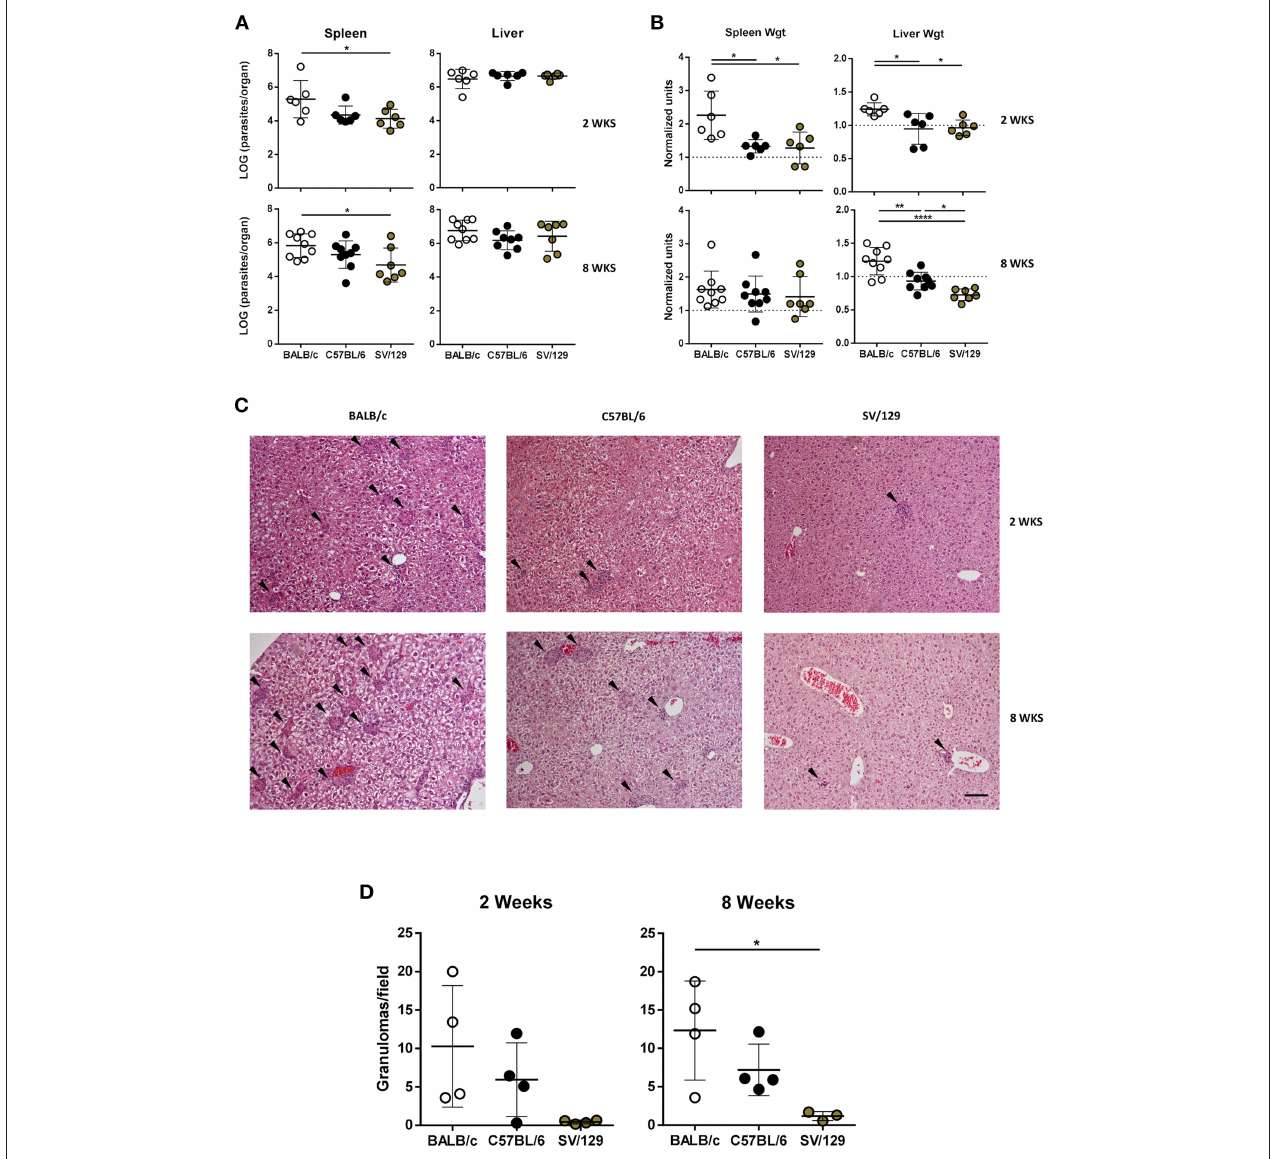
FIGURE 1 | Parasite burdens, organ weights, and hepatic granulomas quantification in the three murine strains 2 and 8 weeks after infection with L. infantum . BALB/c (white circles), C57BL/6 (black circles) and SV/129 (brown circles) mice were infected intraperitoneally with 1 × 10 8 L. infantum promastigotes and euthanized 2 or 8 weeks after. Aged matched non-infected controls were euthanized at the same time-points. (A) Hepatic and splenic total parasite burdens (determined by limiting dilution). (B) Relative splenic and hepatic weight alterations with infection (normalized by the controls average organ weights). (C) Hepatic granuloma morphology (representative images of H&E stained liver slides; 100X magnification; arrowheads point to granulomas; scale bar corresponds to 100 µ m) and (D) quantification. Each dot represents an animal; average and SD of the values within each group are shown (A,B,D) . Results are representative of at least two independent experiments. Statistical differences are properly identified (One-Way ANOVA (with Tukey’s post-hoc analysis): * p ≤ 0.05, ** p ≤ 0.01, and **** p ≤